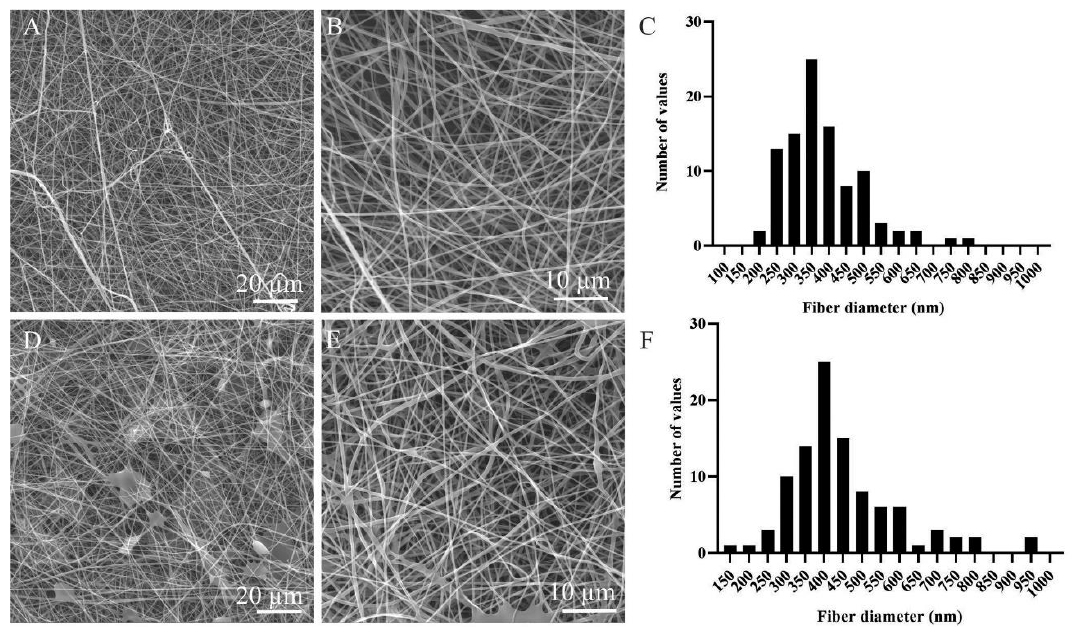
Figure 1. Scanning electron microscope (SEM) images of the electrospun poly(vinyl alcohol) (PVA) ( A , B ) and PVA–platelet lysate (PL) ( D , E ), magnification × 2000 (scale bar = 20 µm) and × 5000 (scale bar = 10 µm), respectively. Histograms of the fiber diameter distributions of the PVA ( C ) and PVA–PL ( F ) nanomats.